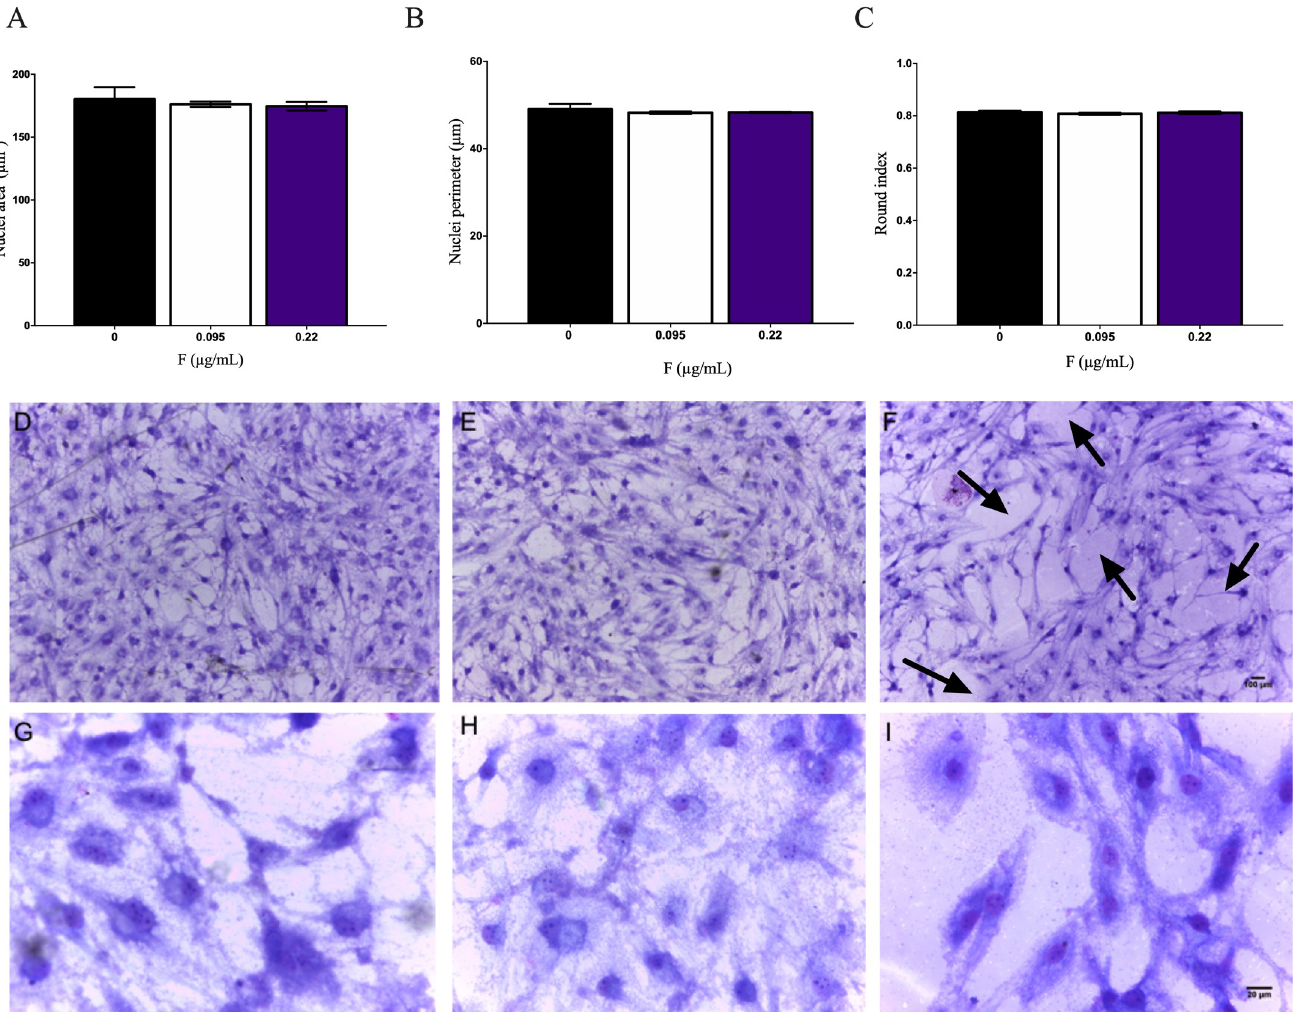
Fig 5. U87 cells morphometric analyses after 10 days of F exposure to 0.095 and 0.22 μ g/mL. Cells were stained by 10% Giemsa and cellular morphology was observed under inverted phase contrast microscope and photomicrography were analyzed by ImageJ. The following parameters were evaluated: A) Nuclei area B) nuclear perimeter and C) rounded index were evaluated. Photomicrography of control (D and G), 0.095 μ g/mL (F and H) and 0.22 μ g/mL (F and I). Data were expressed as mean ± SD. Arrows shows decreased cellular density and narrowing of cytoplasmic